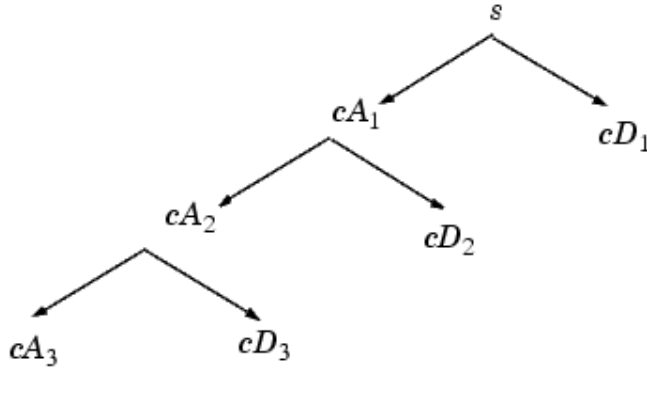
Figure 2. Structure of discrete wavelet decomposition at level